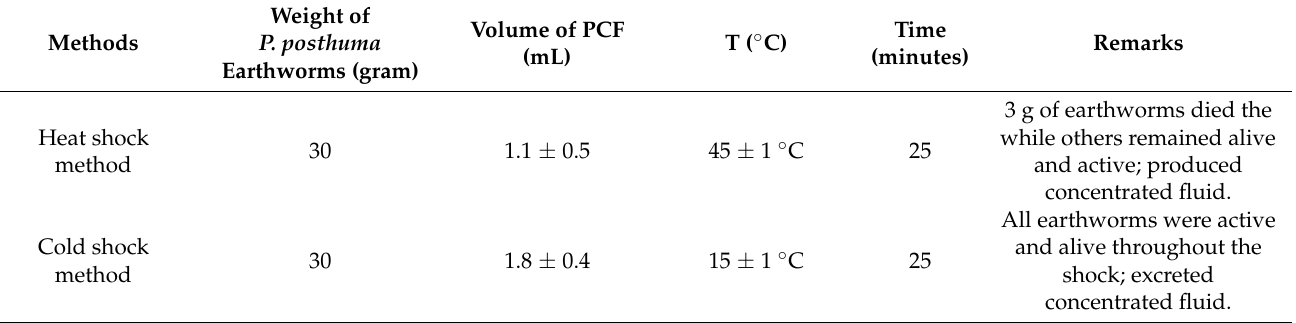
Table 1. Comparison of PCF collection methods based on volume, temperature, and